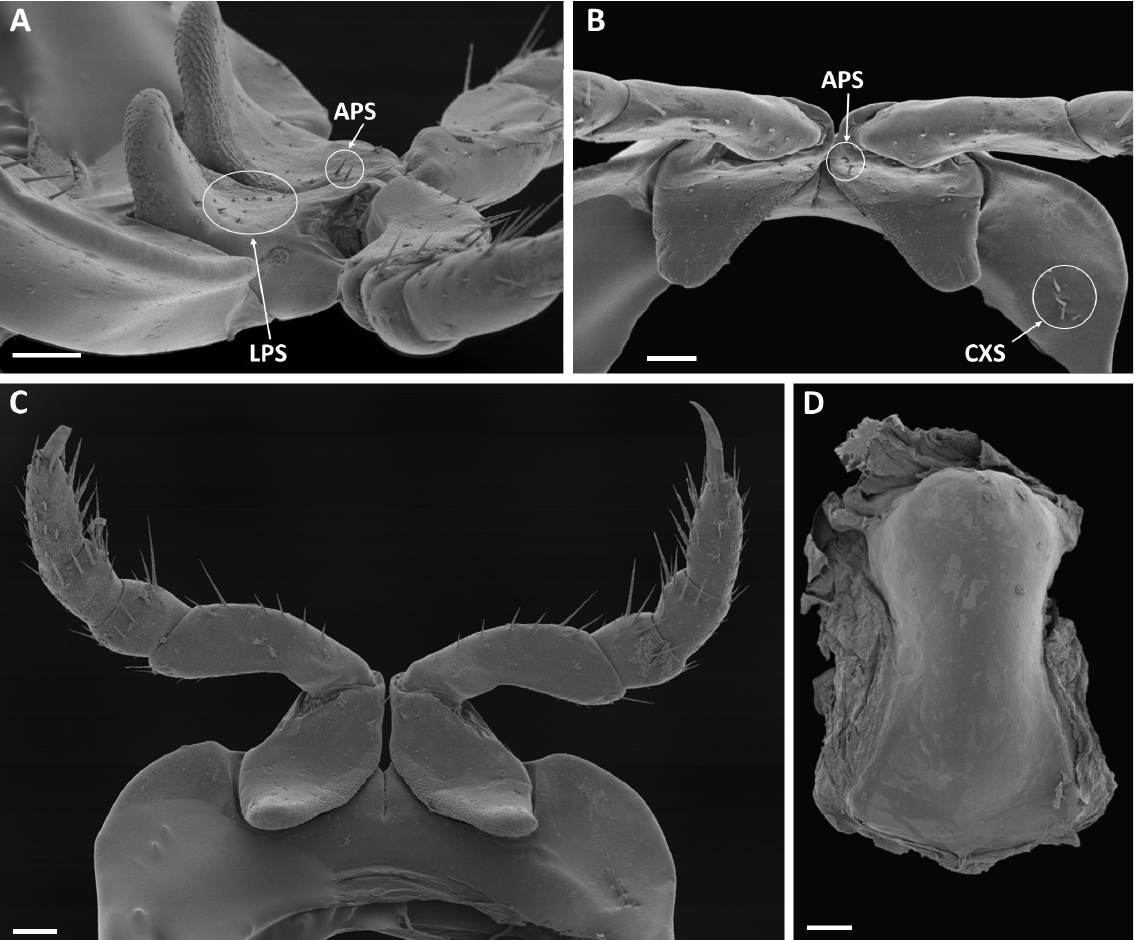
Fig. 43. Multipronopea agneteae gen. et sp. nov., paratype, ♂, from Chamayani F.R. (NHMD 621750). A–C . First pair of legs. A. Sublateral view. B. Ventral view. C. Anterior view. D . Sternum